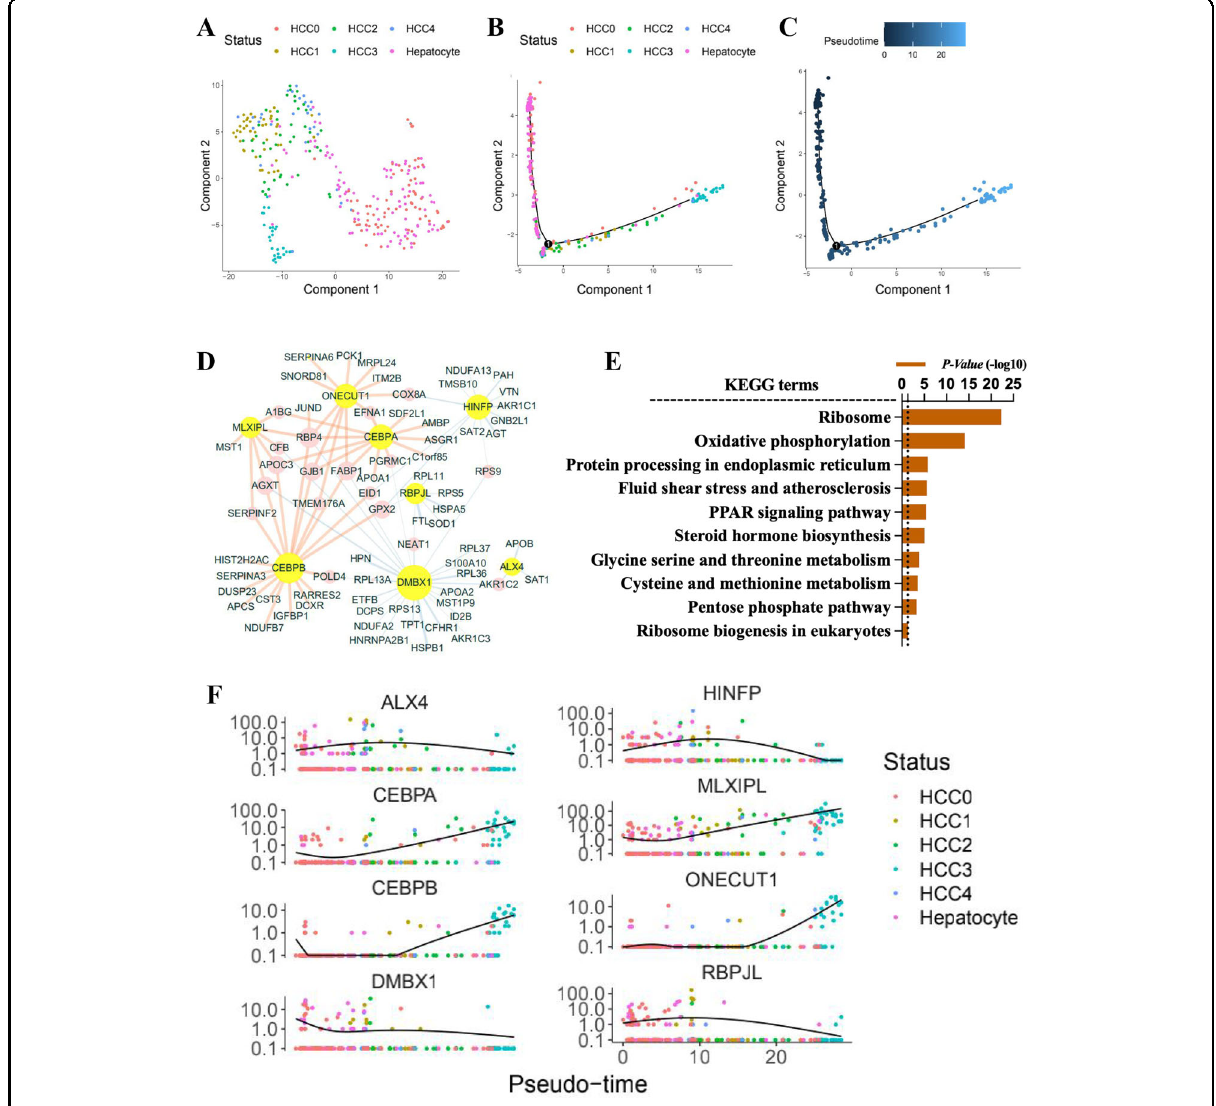
Fig. 4 Cellular trajectory pattern and its major driving genes. A An unsupervised t-SNE plot showed sporadic distributed fi ve HCC clusters in HCC tissues, and hepatocellular cells in para-tumor tissues. B Cellular trajectory of fi ve HCC cells subpopulations and para-tumor hepatocytes. The t-SNE plot revealed the distribution of single cells determined by Monocle. C The direction of the cellular trajectory determined by unsupervised pseudo- time. D Regulatory co-networks of cellular trajectory-related transcription factors and their regulated genes. Genes in yellow circles were the most critical transcription factors. E GOBP functional annotation related to the cellular trajectory. F Plots showed the trends of expression pro fi les of eight key transcription factors in different subclones as